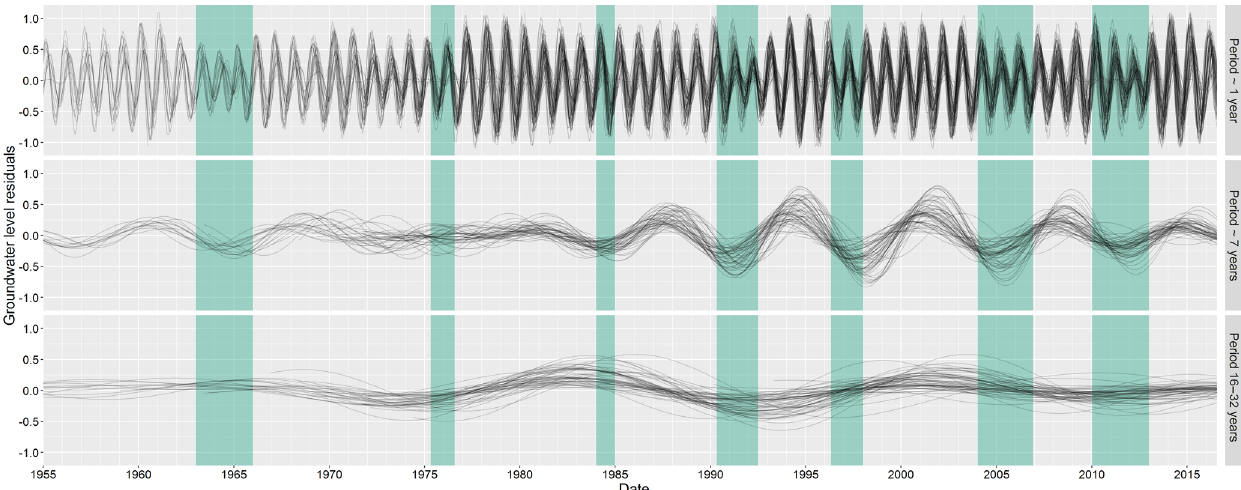
Figure 4. Overlaid reconstructions of the three key periodic domains found across the 59 groundwater wavelet spectra are shown. All periods (both significant and non-significant) within these bands have been displayed to allow for comparison of period strength and phase over time. Areas shaded green represent approximate periods of significant droughts in the UK. Only reconstructions between 1955 and 2017 are shown to allow clearer comparison.